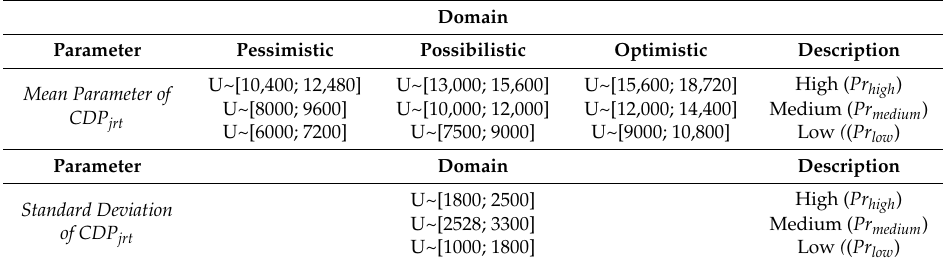
Table A4. Random fuzzy parameters.